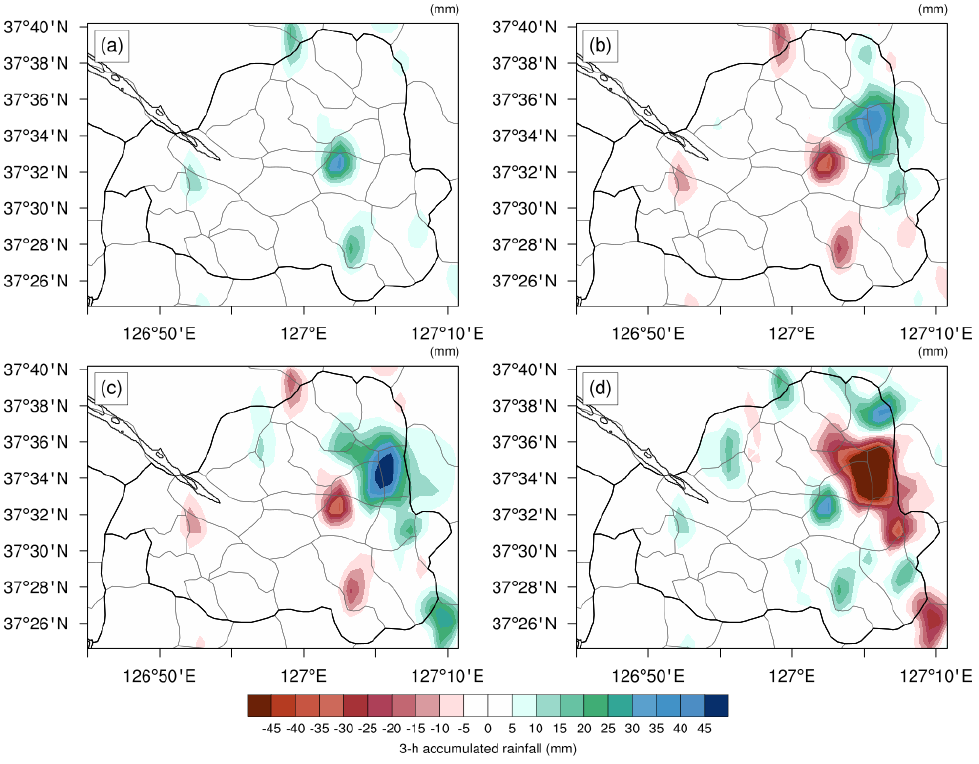
Figure 11. 3-h accumulated rainfall (mm) ( a ) unrelated to either urban roughness or anthropogenic heat, ( b ) induced by urban roughness, ( c ) induced by anthropogenic heat, and ( d ) induced by the interaction between urban roughness and anthropogenic heat from 1500 to 1800 LST.